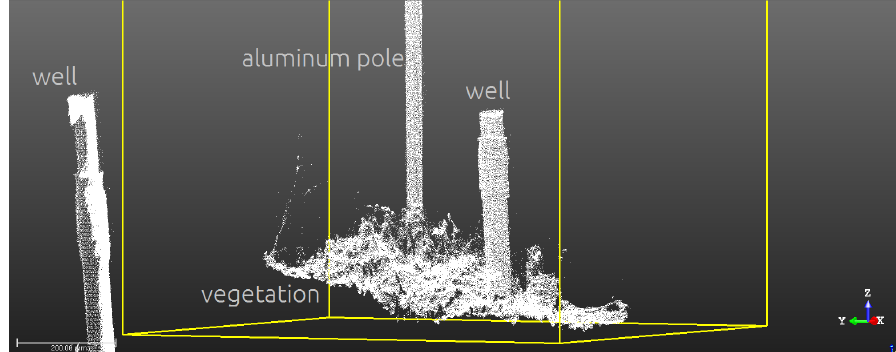
Figure 4. Example of the point clouds for manually identified wells. The well (on the right and in the foreground on the left), filter sock, the aluminum pole (in the middle, with the top cut off) marking the well, and surrounding vegetation are clearly visible in the point